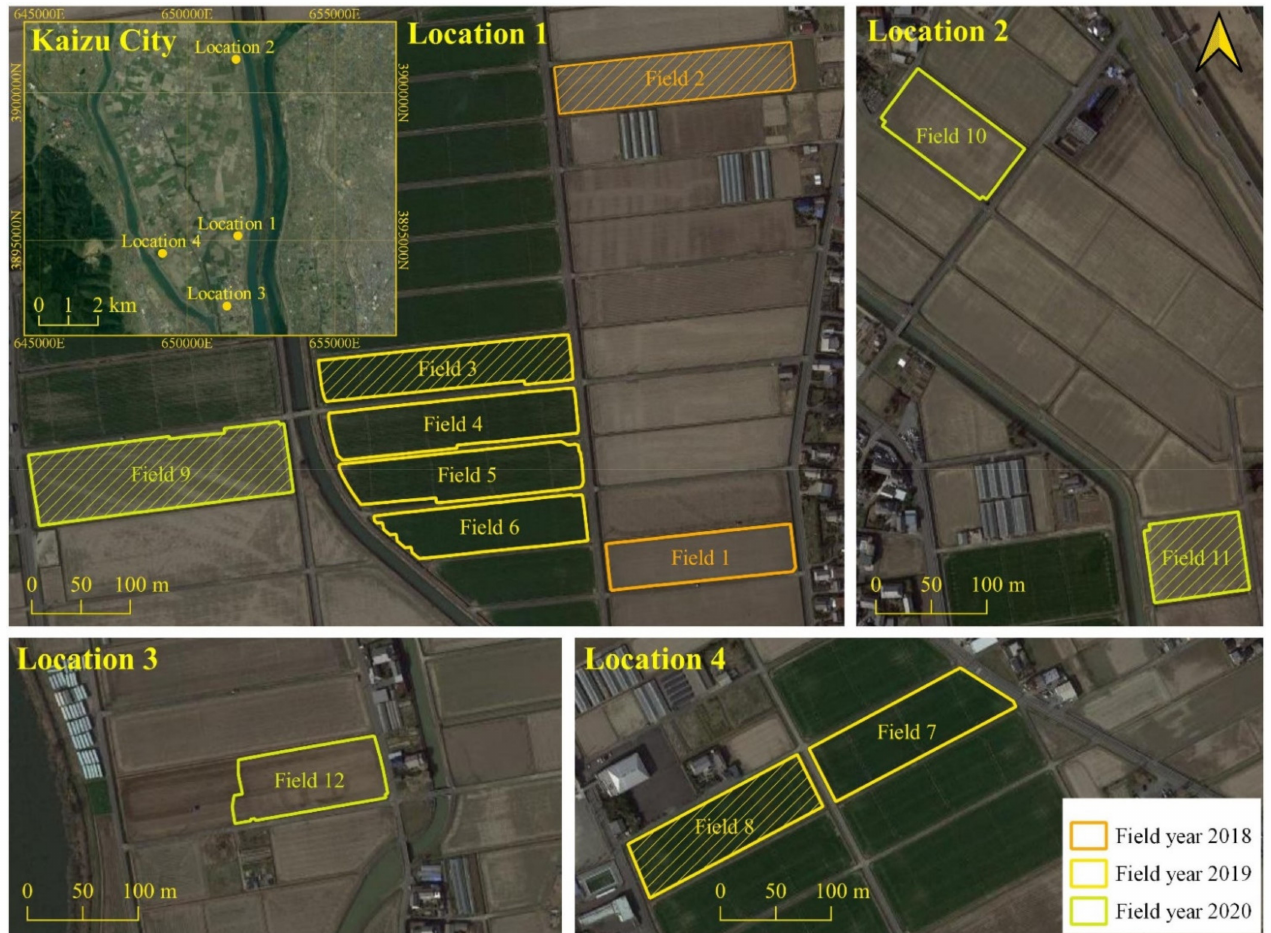
Figure 2. Location of study sites at Kaizu city, Gifu Prefecture, Japan. Shaded fields indicate test